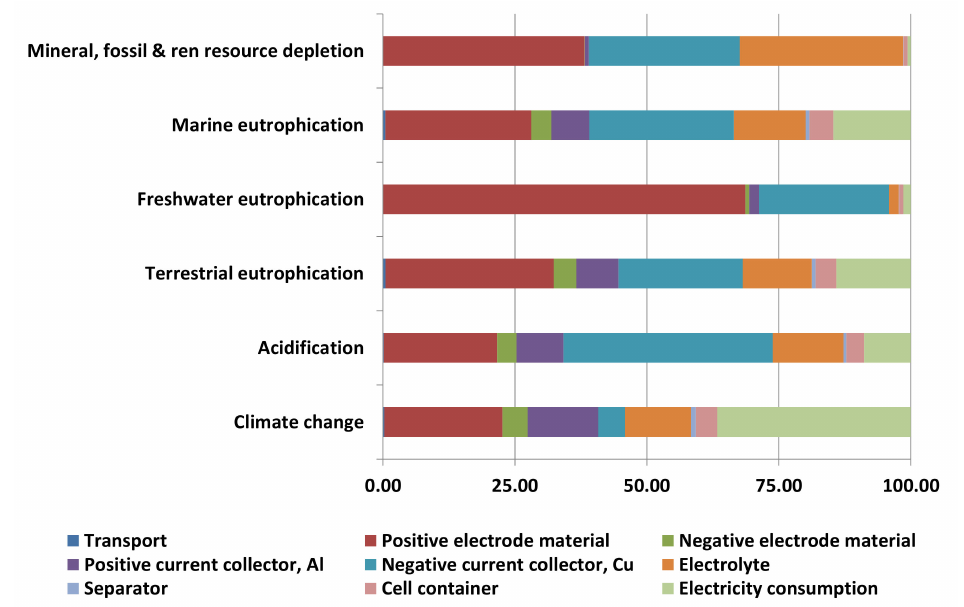
Figure 5. Life cycle impacts of LFP battery cell production, broken down into key processes.